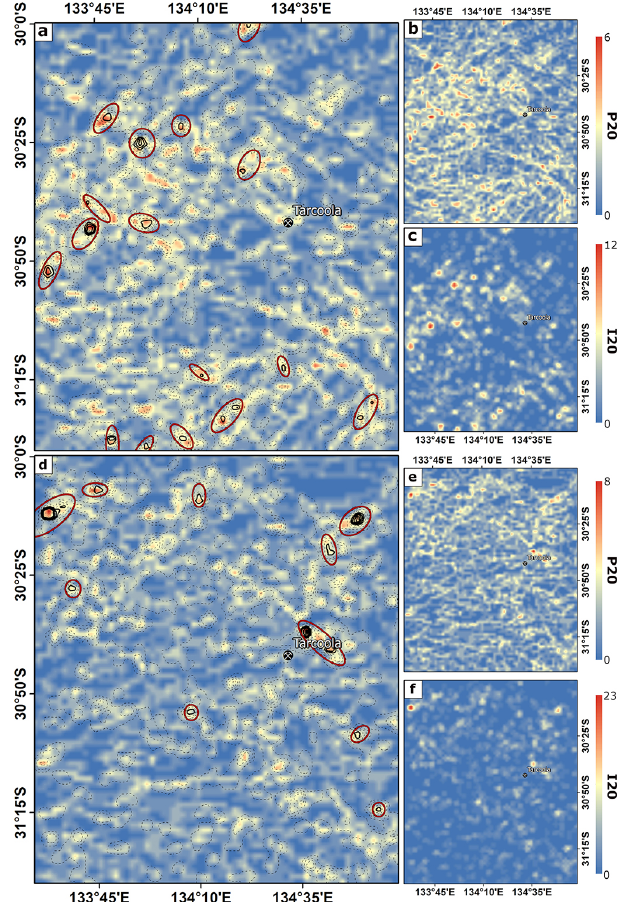
Figure 13. (a) Targeting map derived from “surface auto” and the structural interpretation. (b) Lineament density map (P20). (c) Inter- section density map (I20). (d) Targeting map derived from “surface manual” and the “subsurface worm”. (e) Lineament density map (P20). (f) Intersection density map (I20). Potential targeting areas are indicated by red